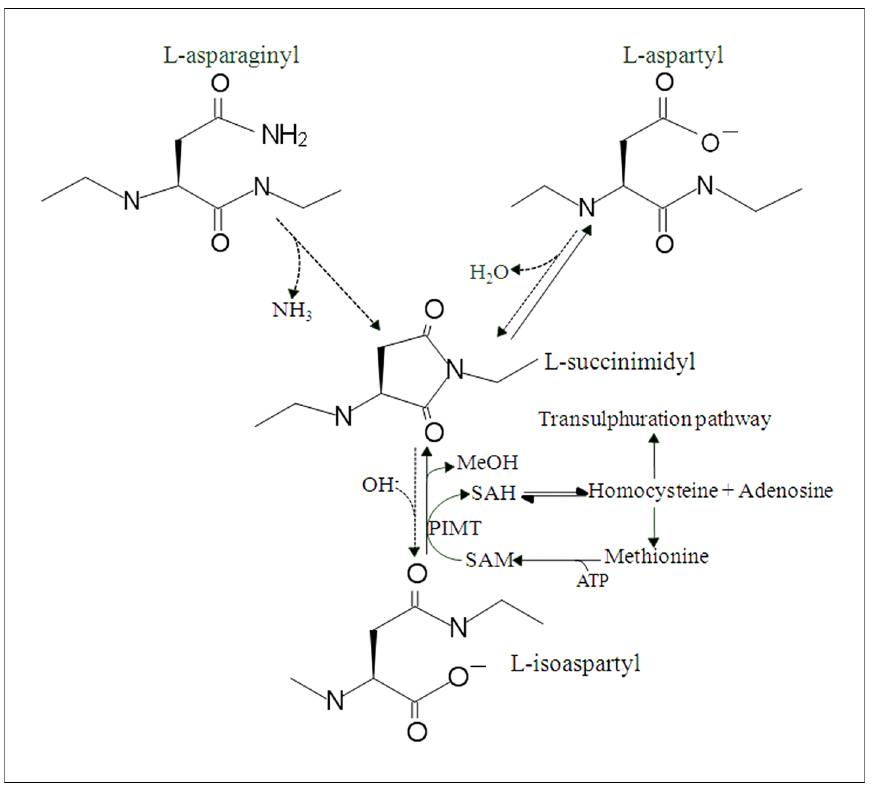
Figure 1. Isoaspartate protein damage formation and PIMT-mediated protein repair. Within a peptide backbone, non-enzymatic deamidation of an asparagine-Xaa linkage or dehydration of an aspartic acid-Xaa linkage can give rise to a five-carbon succinimide (indicated by the dashed arrows). Succinimide hydrolysis (OH 2 ) yields an isoaspartate residue (major product, indicated by the dashed arrow), or an aspartic acid (minor product, indicated by the right solid arrow). PIMT utilises SAM to carboxyl-methylate the isoaspartate forming a methyl ester that readily hydrolyses under physiological conditions to liberate methanol and reform the five-carbon succinimide (lower solid arrow). Subsequent succinimide hydrolysis will again yield isoaspartate or ‘repaired’ aspartate products (right solid arrow). PIMT activity is influenced by the levels of SAM and SAH, which are likewise governed by the enzyme and metabolite levels of the methionine metabolic pathway.